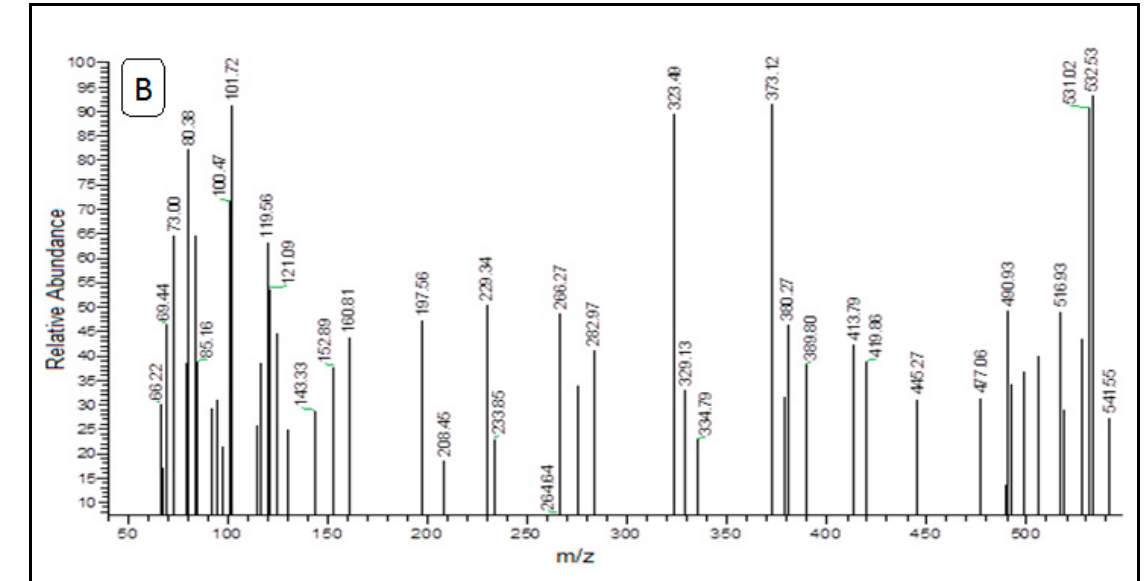
Figure 5. The mass spectrum of ( A ) NiSQ and ( B ) CdSQ mixed ligand metal complexes.